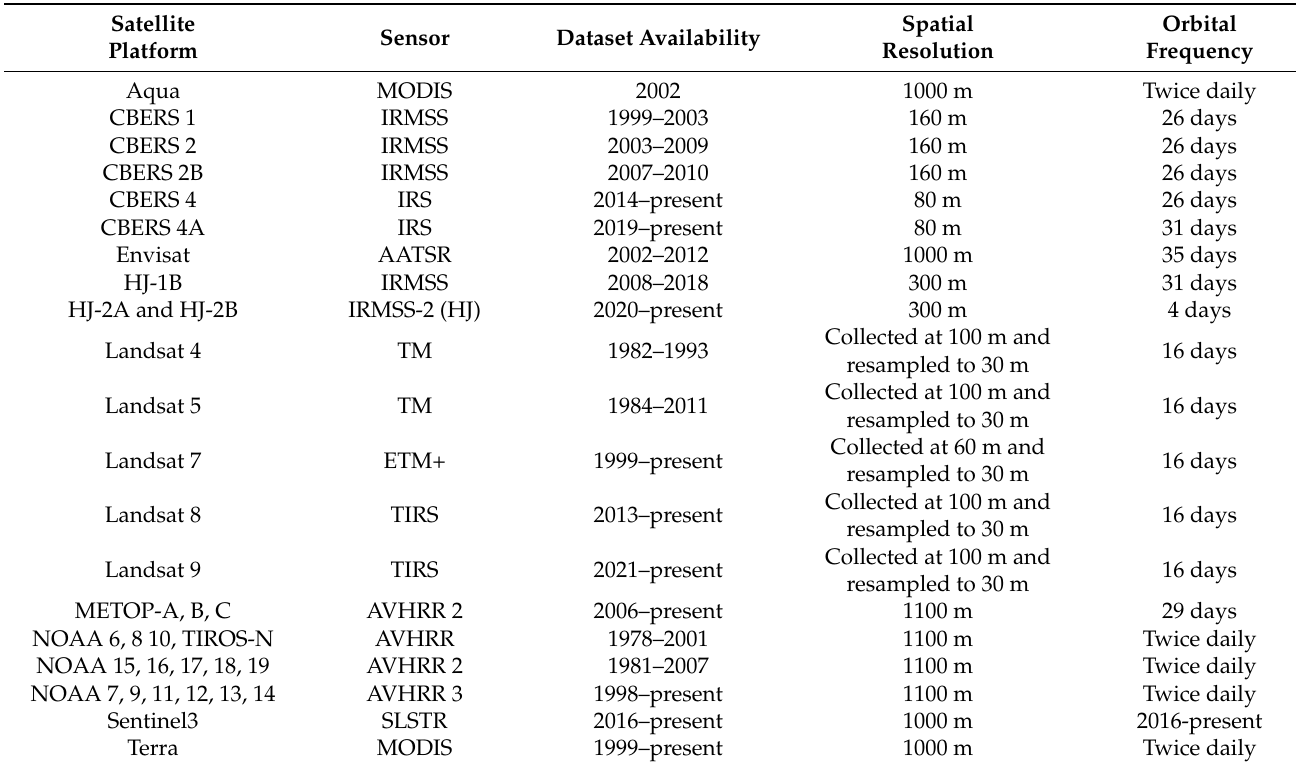
Table 1. Satellite images for thermal environment studies at urban scale (adapted from